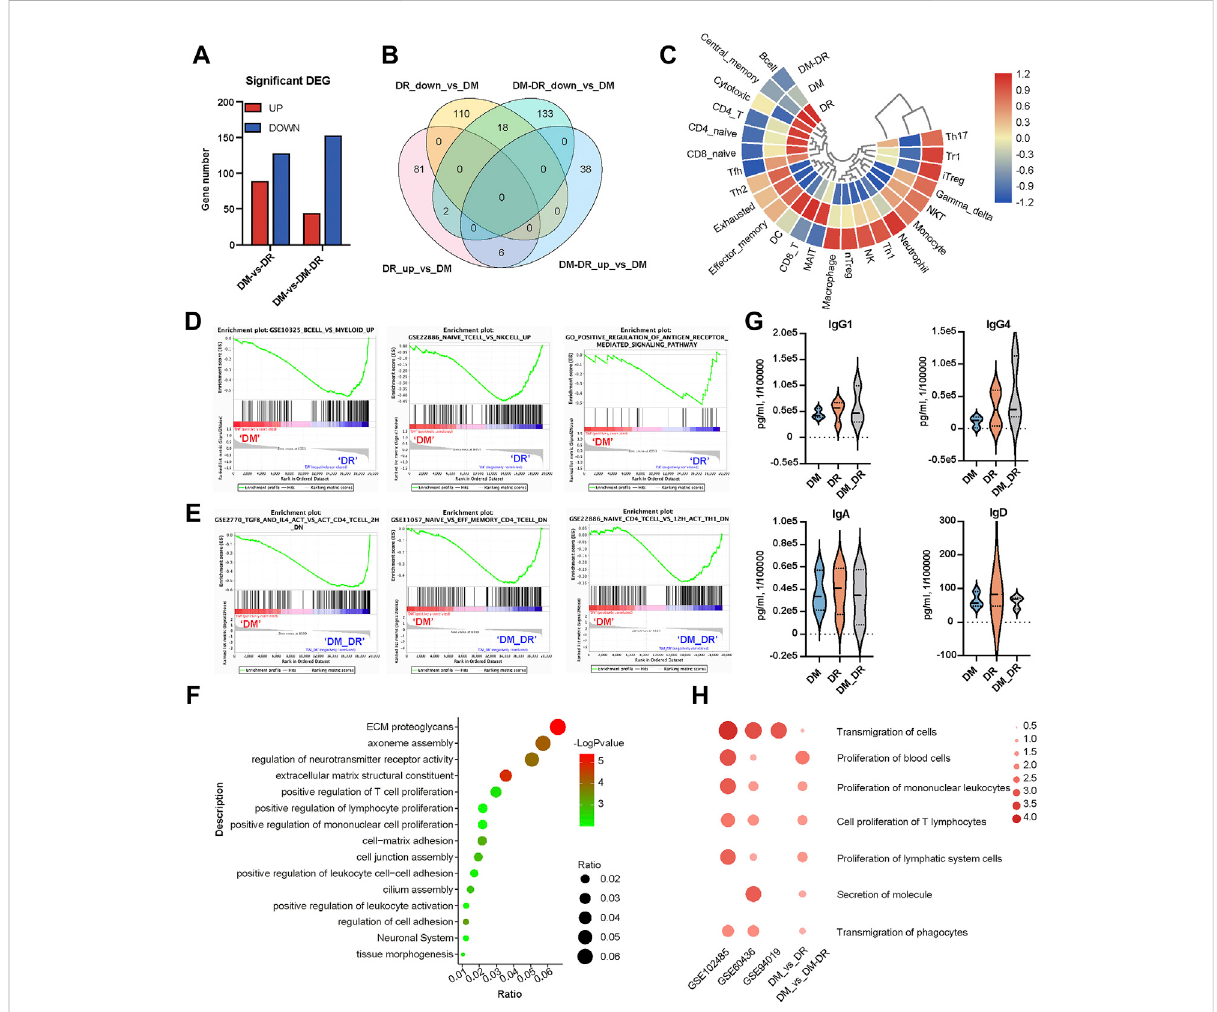
FIGURE 5 Diabetes-relateddiseaseandfunctionanalysisofdifferentlyexpressedgenes(DEGs)enrichedinpatientswithoculopathy. (A) barchartofDEGs among diabetic retinopathy (DR), non-DR (DM), and DM – DR groups. (B) Venn diagram of DEGs among the indicated comparison groups. (C) heat map-based ImmuCellAI and Timer2 platforms of the immune cell abundance from the RNA-seq data. (D,E) gene set enrichment analysis datasets enriched in DR (D) and DM – DR (E) upregulated gene clusters compared with the DM group. (F) functional analysis of DR upregulated DEGs vs. DM by Metascape. (G) plasma levels of immunoglobulin subtypes were measured using a cytometric bead array assay. (H) heatmap of the selected diseases and functions by ingenuity pathway analysis across the DEGs of DM, DR, and DM – DR and Gene Expression Omnibus datasets of ocular